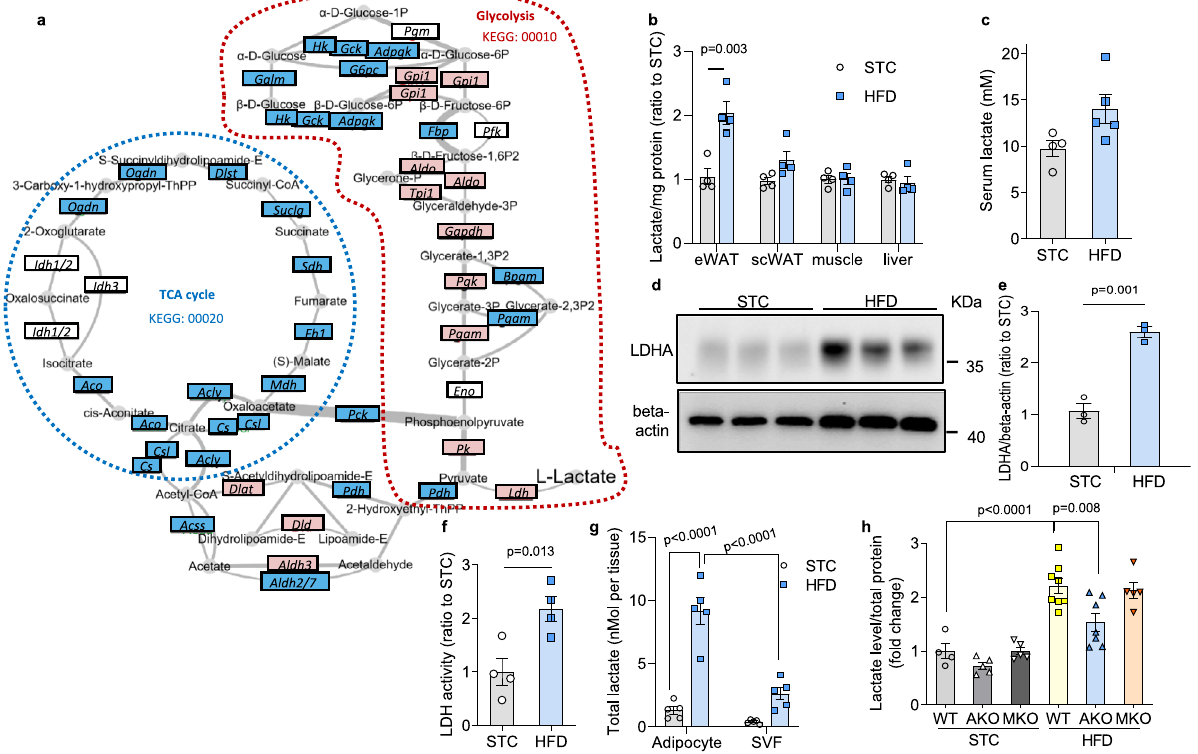
Fig. 1 | Lactate production in adipocyte is increased in diet-induced obesity. a Gene expression changes in glucose metabolic pathways (KEGG ID mmu00010 and mmu00020) in epididymal white adipose tissue (eWAT) of C57BL/6 mice fed with low orhigh fatdiet for3 months. Originaldata wereobtained from GSE91067 (GSM2420432 - GSM2420439). Genes signi fi cantly up- or downregulated in obese eWAT were highlighted in pink (Up) and blue (Down). Width of the edge is pro- portionalto thefoldchangeof the gene. b – h 8-week-oldmale C57BL/6J micewere fedwithstandardchow(STC)orhighfatdiet(HFD)for3months. b – c Lactatelevels in b different tissues ( n =4 biologically independent animals) and in c serum (STC: n =4; HFD: n =5 biologically independent animals) of mice. d Western blotting of